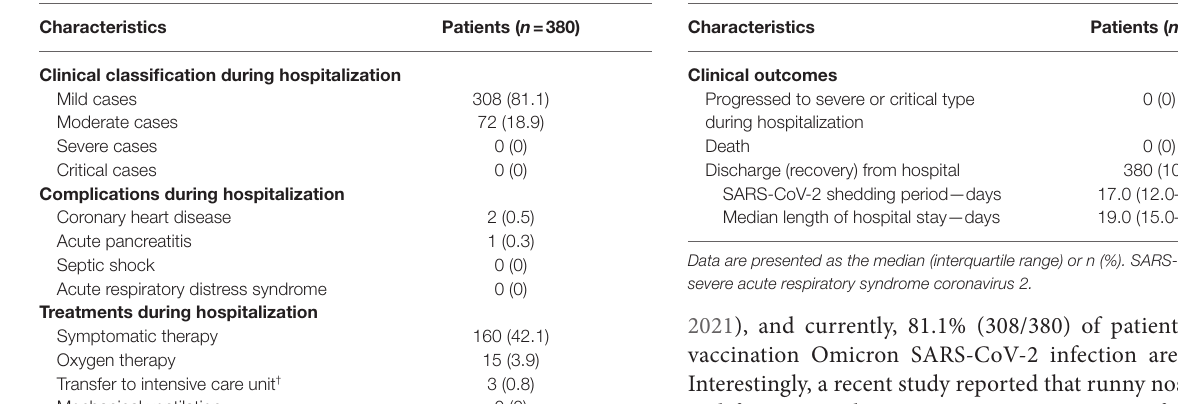
TABLE 5 | Clinical characteristics of patients during hospitalization. TABLE 6 | Patient clinical